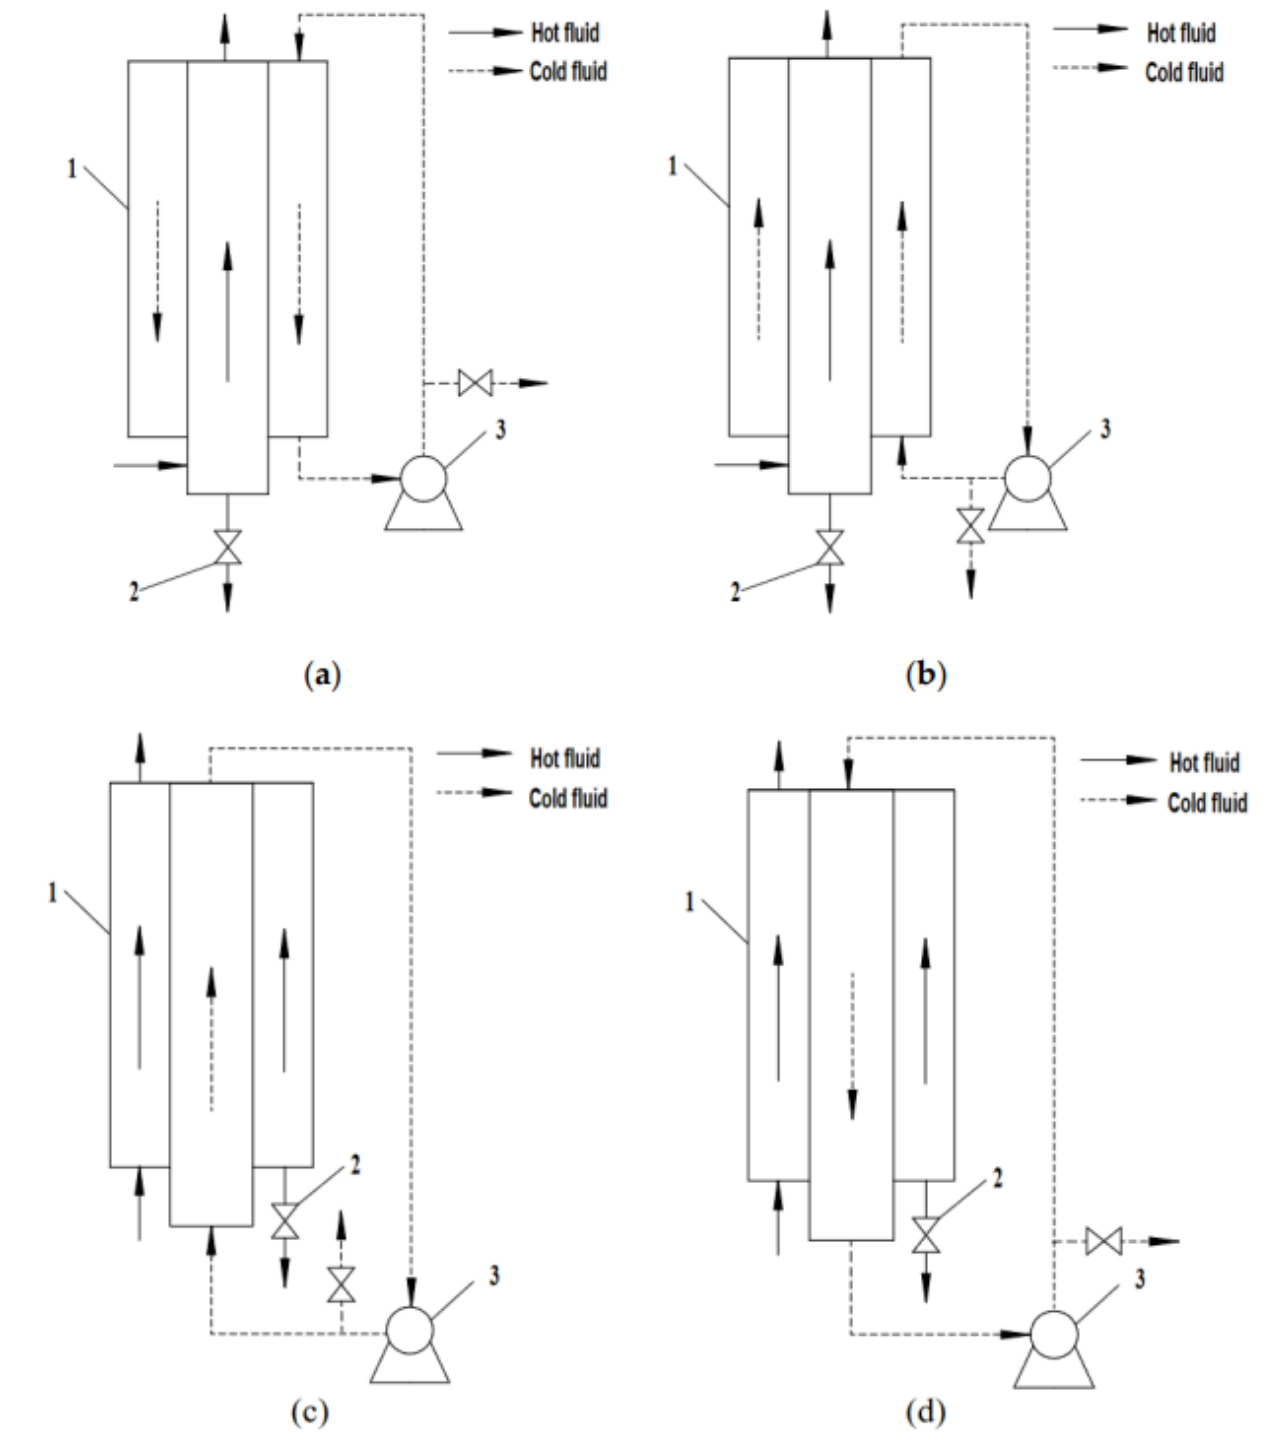
Figure 1. Schemes of the convective heat transfer between the pyrolysis steam and the cold fluid (( a ) scheme 1; ( b ) scheme 2; ( c ) scheme 3; ( d ) scheme 4): (1) dual tube heat exchanger; (2) ball valve; (3) circulating pump.